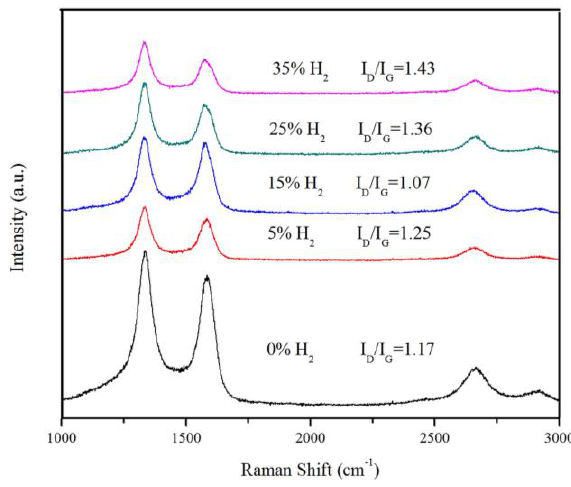
Figure 4. Raman spectra of VACNTs created under various hydrogen concentrations.